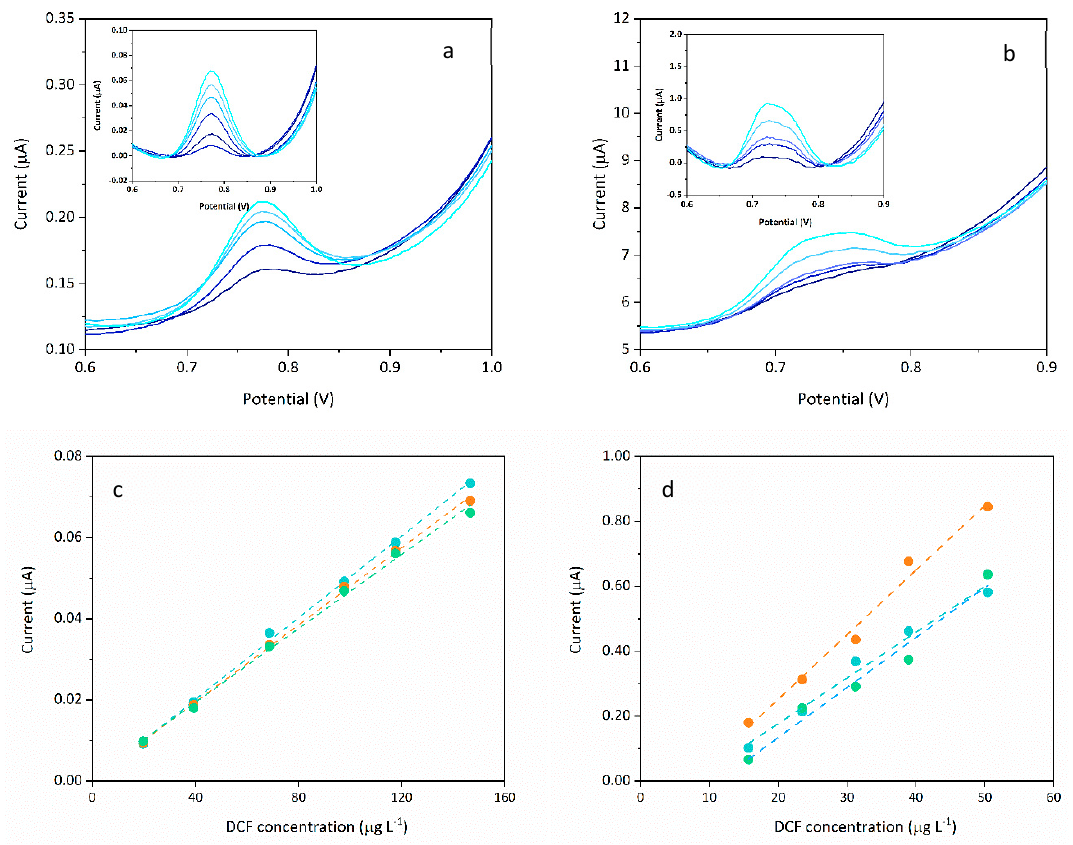
Figure 8. ( a ) Peaks obtained by solution DPV analysis with aSPCE1 on 20–146 µ g L − 1 DCF solutions (1.0 × 10 − 1 mol L − 1 PB, pH 2.0; E vs. Ag/AgCl); the inset graph shows the peaks after baseline subtraction; ( b ) Peaks obtained by solution DPV analysis with aSPCE2 on 15–50 µ g L − 1 DCF solutions (1.0 × 10 − 1 mol L − 1 PB, pH 2.0; E vs. Ag/AgCl); the inset graph show the peaks after baseline subtraction; ( c ) linear fit of signals recorded by solution DPV analysis with aSPCE1 on 20–146 µ g L − 1 DCF solutions; ( d ) linear fit of signals recorded by solution DPV analysis with aSPCE2 on 15–50 µ g L − 1 DCF solutions. Table 3. Linear fit parameters estimated on current signals recorded by solution and drop DPV analysis with aSPCE. Electrode Linear Fit Parameters Solution